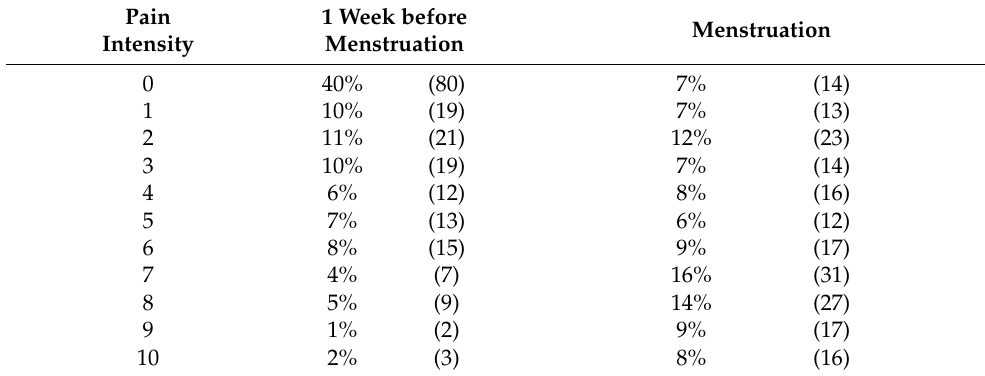
Table 1. Pain intensity one week before and during menstruation.